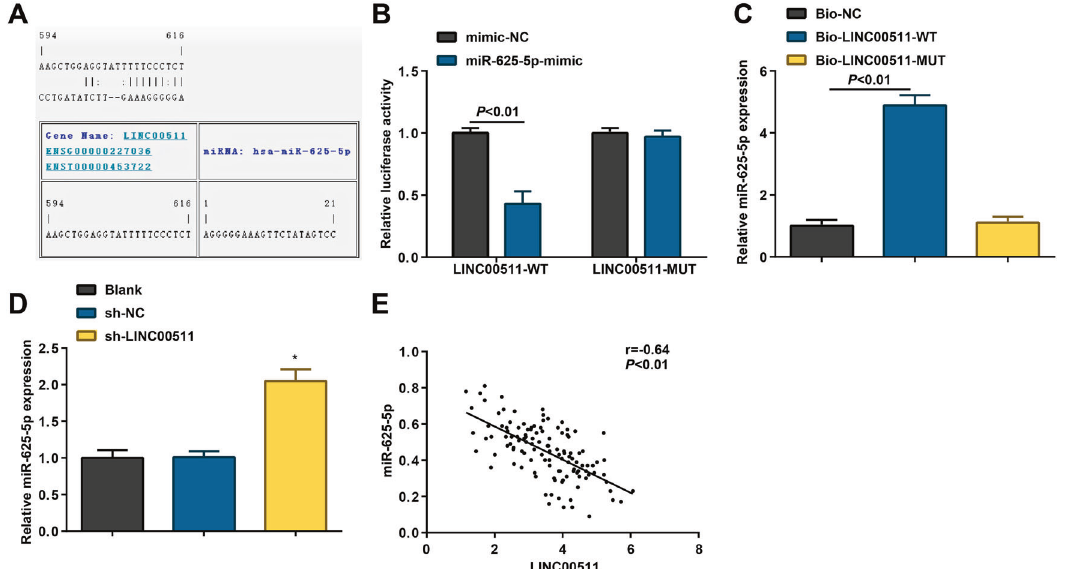
Fig. 4 LINC00511 negatively targets miR-625-5p. A RNA22 predicted the binding site of LINC00511 and miR-625-5p; B dual-luciferase reporter gene assay detected the targeting relationship between LINC00511 and miR-625-5p; C RNA pull-down assay veri fi ed the targeting relationship between LINC00511 and miR-625-5p; D RT-qPCR detected miR-625-5p expression after knockdown of LINC00511; E Pearson correlation analysis evaluated the correlation between LINC00511 and miR-625-5p in CC tumor tissues ( n = 120); the measurement data are expressed as mean ± standard deviation. N = 3. * P < 0.05 compared with the sh-NC